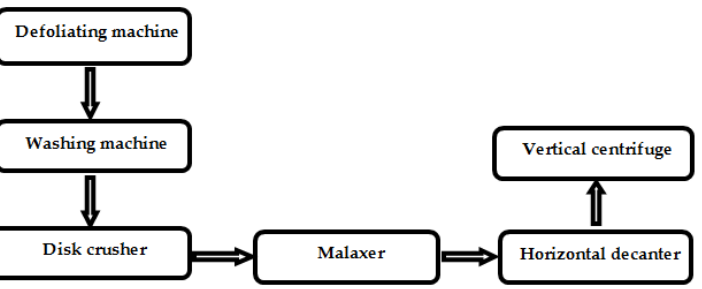
Figure 1. Block diagram of the olive oil mill plant.